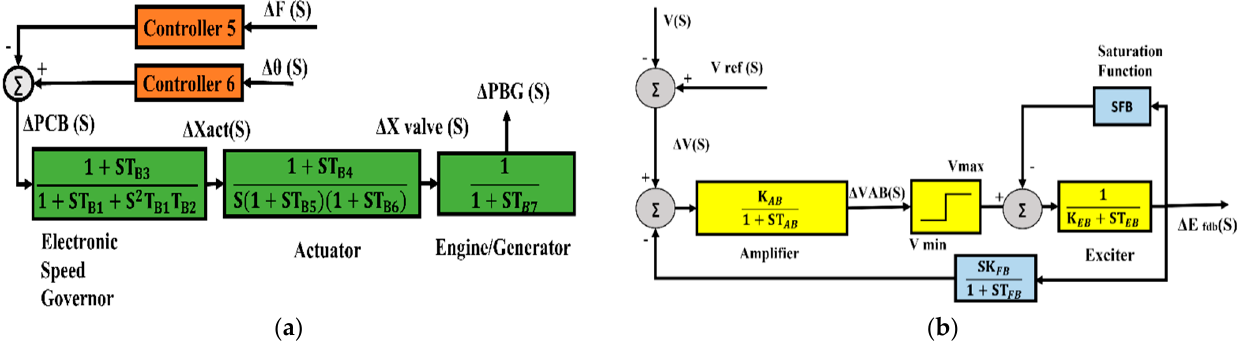
Figure 5. The block diagram of SPVS.